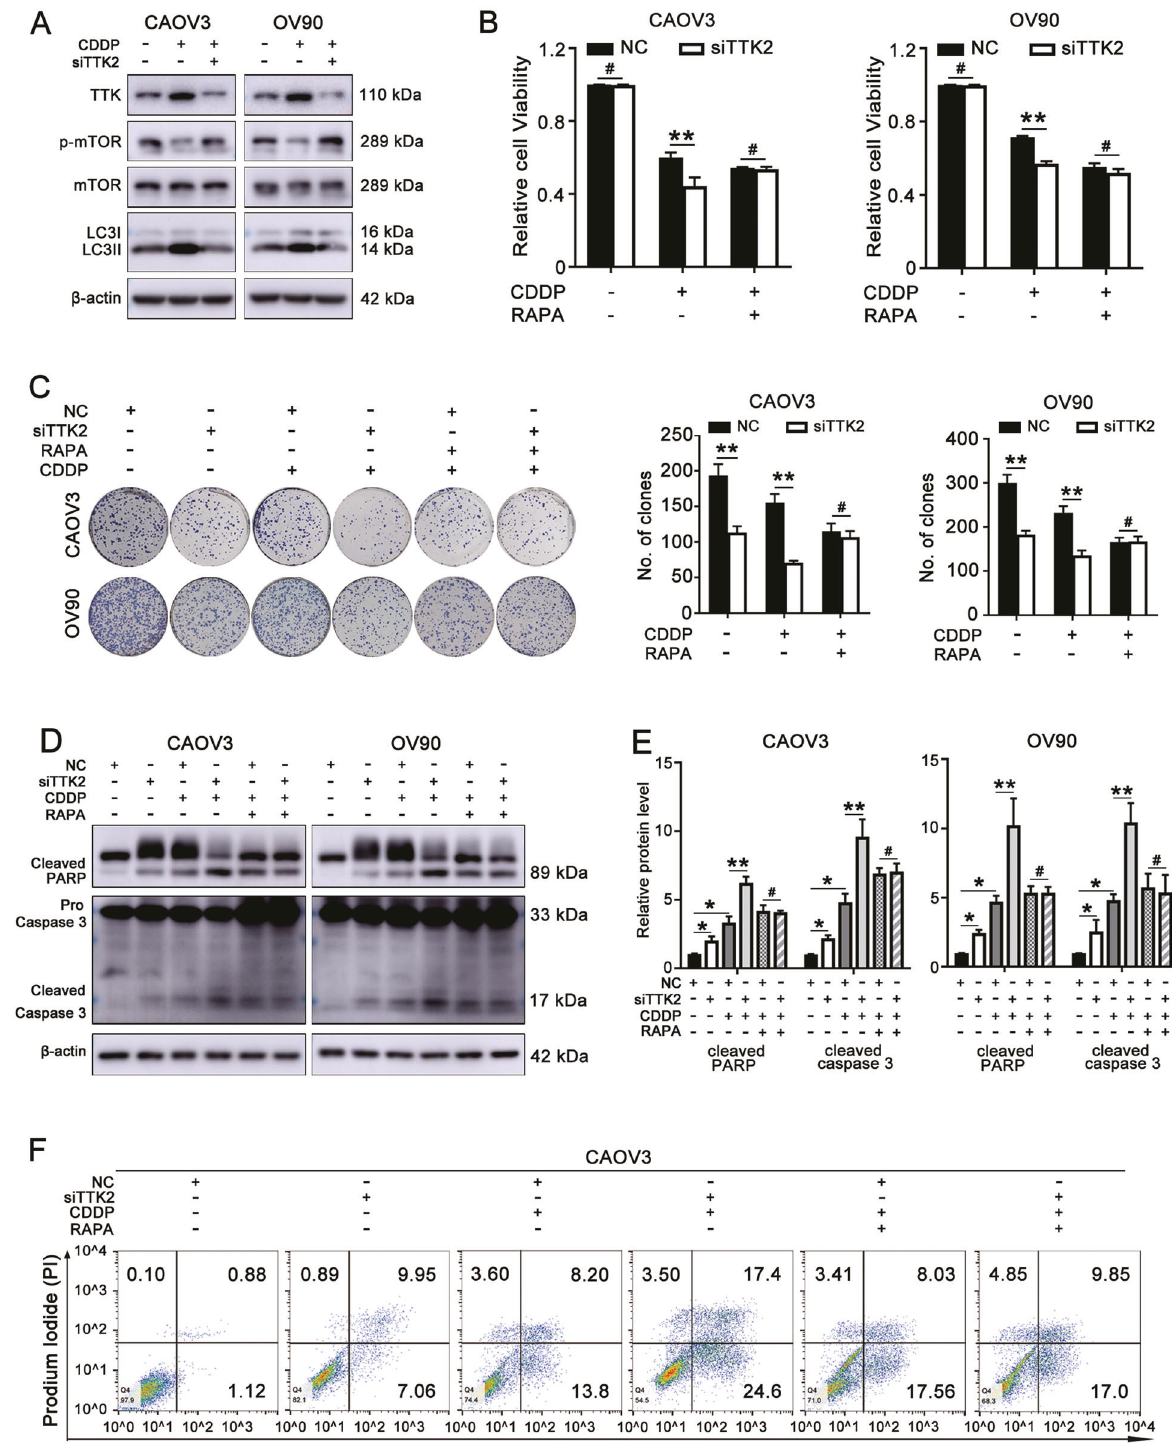
Fig. 7 TTK silencing increases the sensitivity of ovarian cancer to cisplatin through the mTOR/autophagy pathway. A CAOV3 and OV90 cells transfected with NC or siTTK2 were treated with 1 or 2 μ g/ml CDDP for 48 h. The relative protein levels of p-mTOR, mTOR, LC3-I/II and TTK were detected using western blotting. B , C CAOV3 and OV90 cells with or without TTK knockdown were treated with 1 or 2 μ g/ml CDDP alone or in combination with 100 nM rapamycin. Cell viability ( B ) and the colony formation ability ( C ) were detected. D − F CAOV3 and OV90 cells transfected with NC or siTTK2 were treated with 2 or 4 μ g/ml CDDP for 24 h and then treated in combination with or without 100 nM rapamycin for 24 h. D , E The protein levels of cleaved PARP and cleaved caspase-3 were evaluated using western blotting. F Flow cytometry was performed to detect apoptotic cells (data are mean ± SEM, # P > 0.05, * P < 0.05, ** P < 0.01, n = 3).